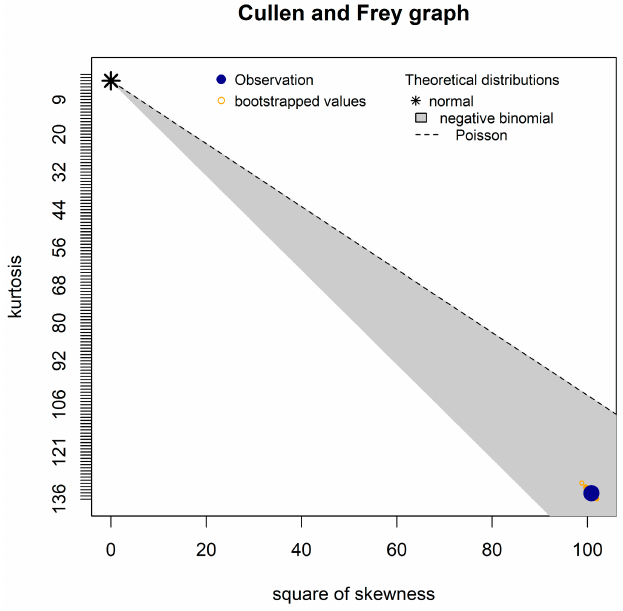
Figure 1. Cullen and Frey graph of delays between contributions of OSM participants with 100 bootstrap samples.